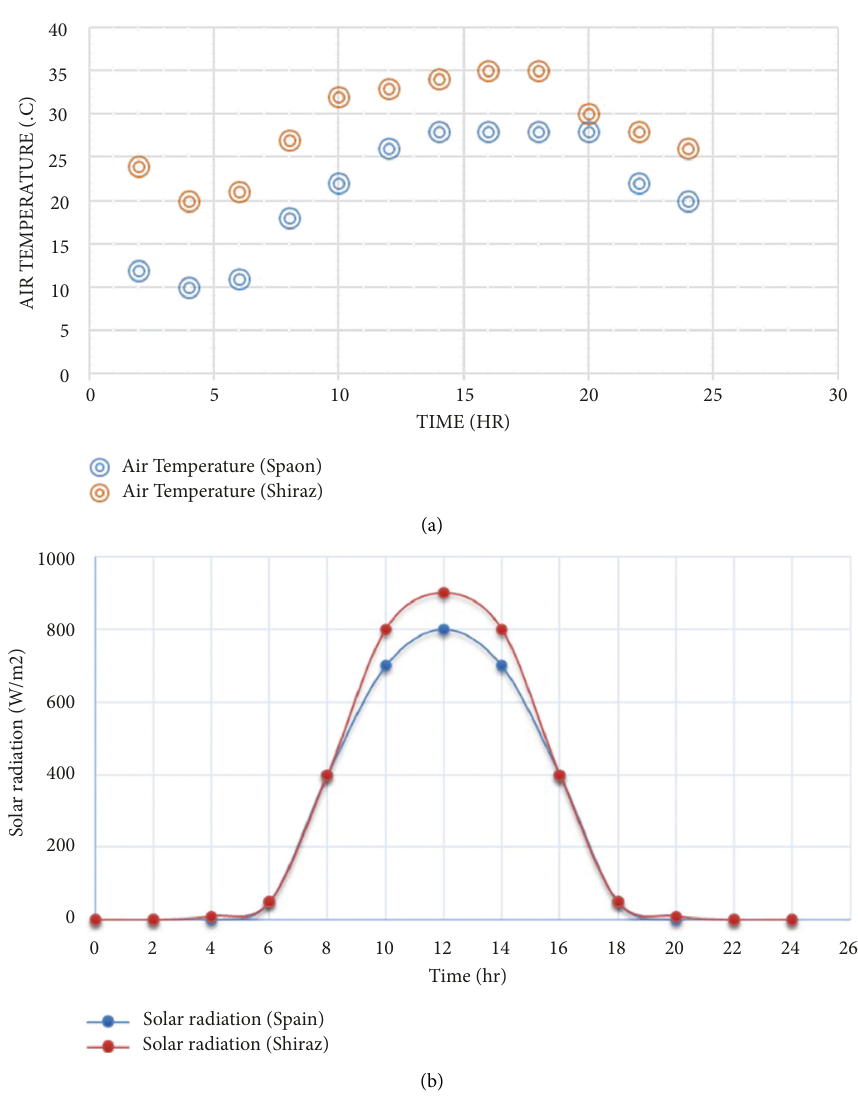
Figure 4: Comparison of (a) ambient temperature and (b) solar radiation between Shiraz and Manzanares on September